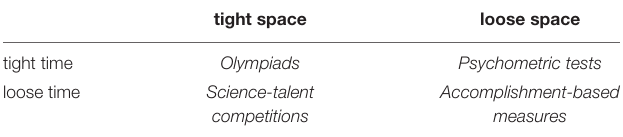
TABLE 1 | Time-space quadrants and measurement